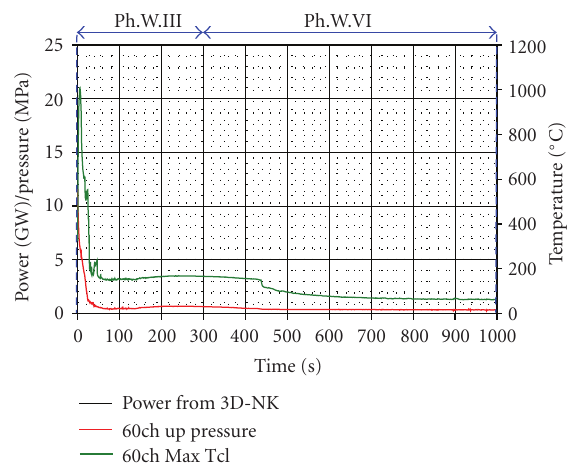
Figure 2: Power, pressure, and maximum cladding temperature, all the transient, “60ch”